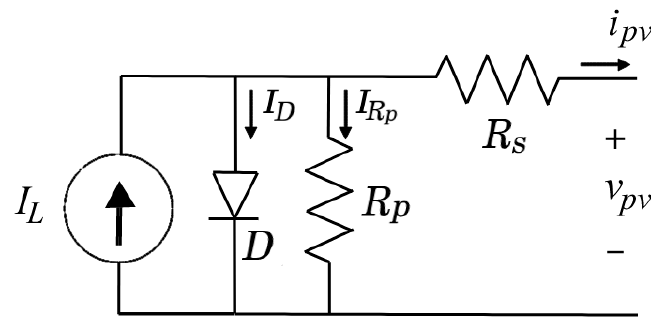
Figure 2. Model of the PV